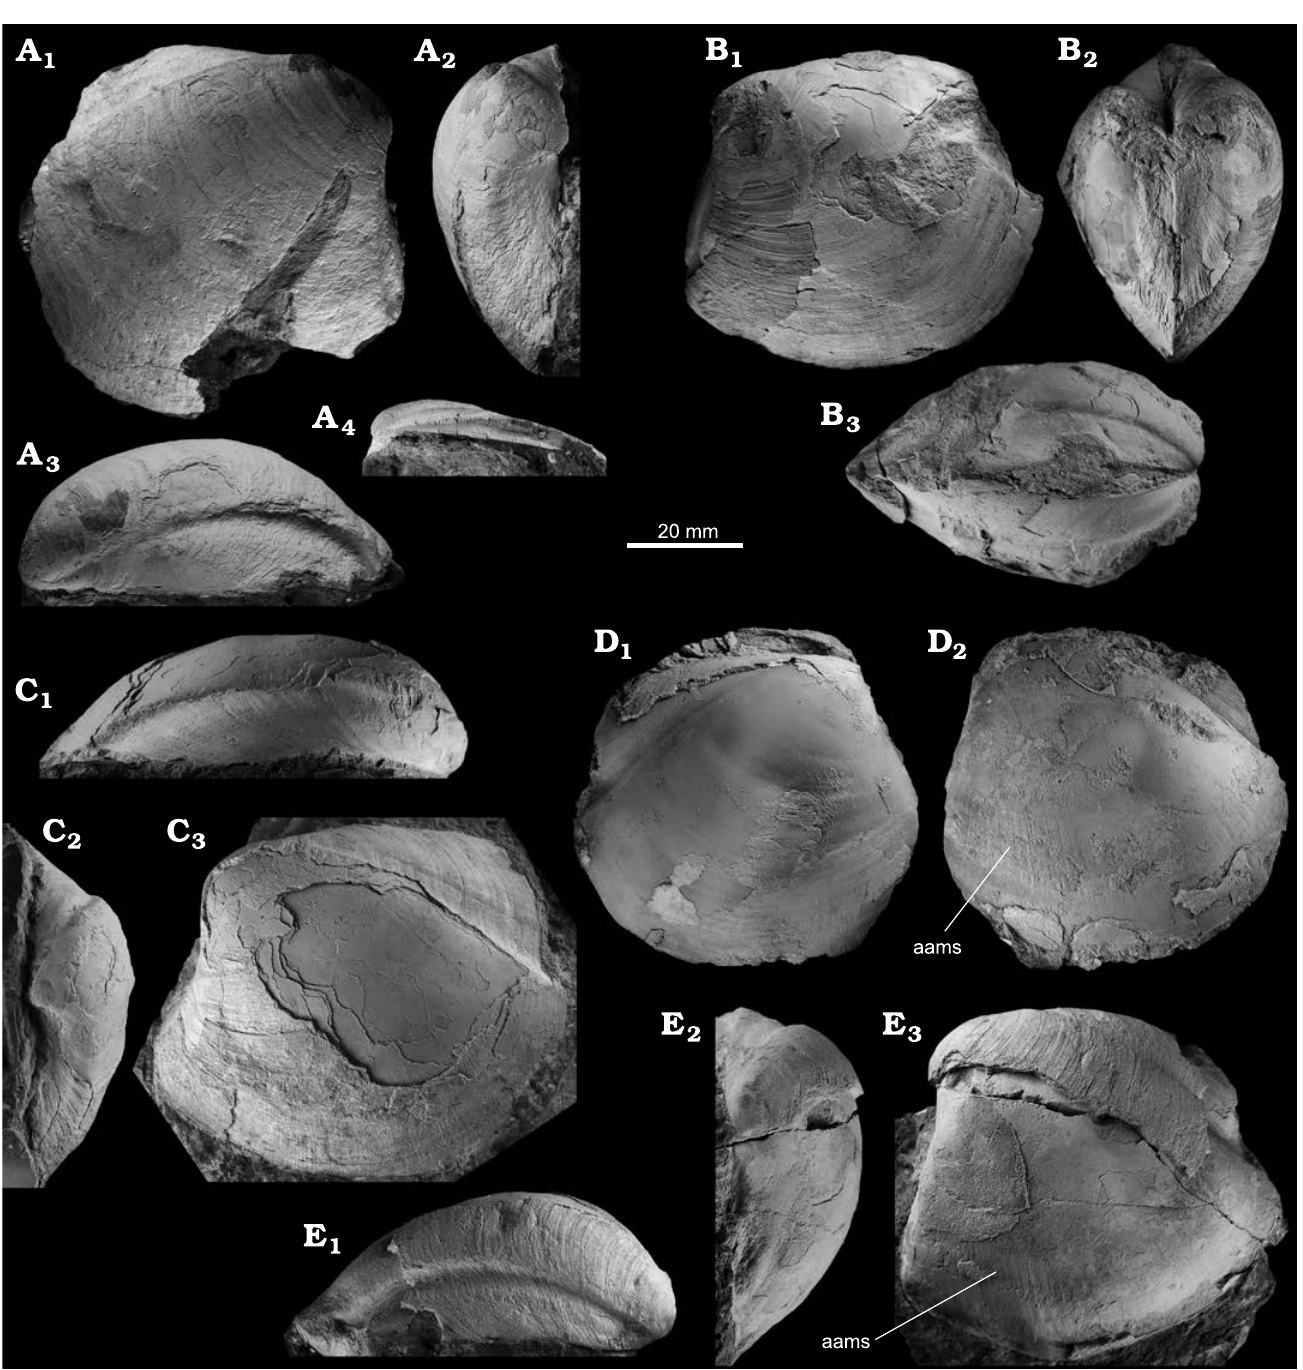
Fig. 6. The thyasirid bivalves Conchocele spp. from Upper Miocene seep deposits of the Amlang Formation in Pangasinan province, Luzon, Philippines. A – D . Conchocele pangasinanensis sp. nov. A . NIGSPAL-009, holotype, isolated RV, view on outer side (A 1 ), seen from anterior (A 2 ), dorsal view (A 3 ) and close-up on hinge and ligament nymph (A 4 ). B . NRM Mo 192588, articulated specimen, view on LV (B 1 ), seen from anterior (B 2 ), and dorsal view (B 3 ). C . NIGSPAL-011, paratype, large LV, dorsal view (C 1 ), seen from anterior (C 2 ), and lateral view (C 3 ). D . NRM Mo 192544, articulated specimen, view on RV (D 1 ) and on LV, showing elongated aams (D 2 ). E . Conchocele aff. quadrata Yabe and Nomura, 1925, NIGSPAL-012, LV, dorsal view (E 1 ), seen from anterior (E 2 ), and lateral view showing aams (E 3 ). Abbreviation: aams, anterior adductor muscle